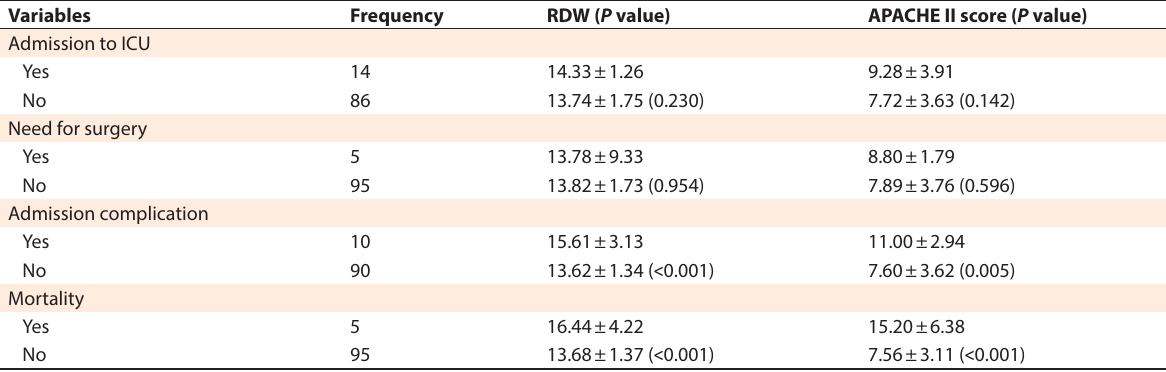
Table 2 . Mean (±SD) of RDW and APACHE II score of patients